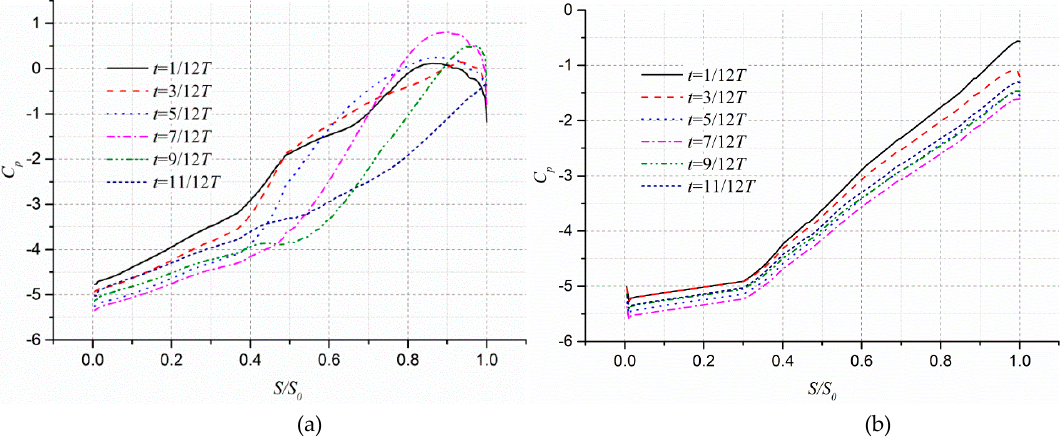
Figure 7. Distribution of the pressure coefficient on the blade surface for the Z / b 2 = 0.5 cross section: ( a ) pressure surface and ( b ) suction surface. ( a ) pressure surface and ( b ) suction